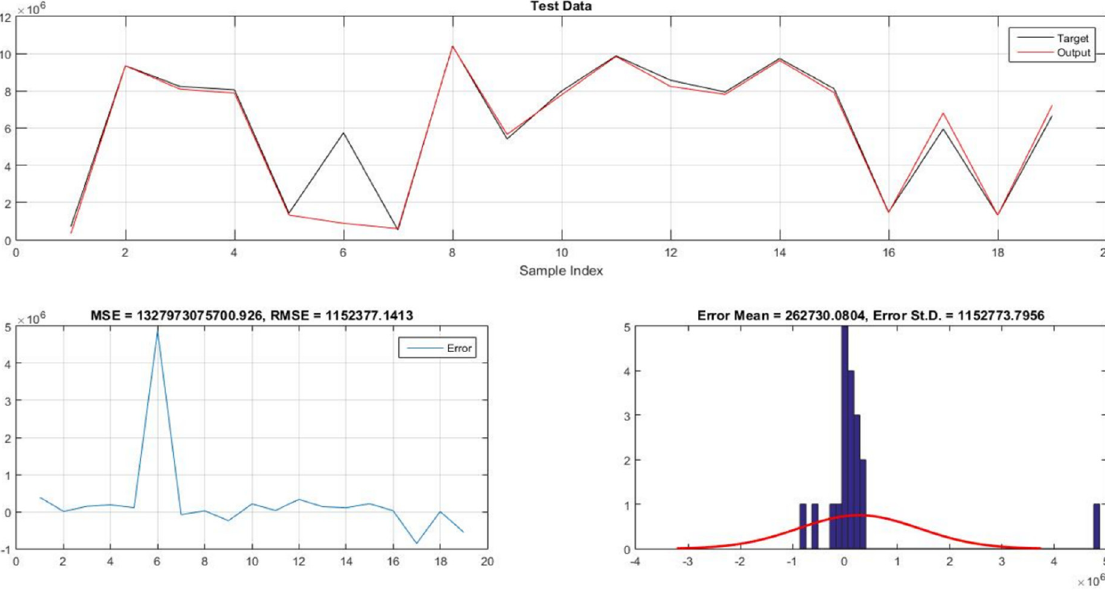
Figure 10. The ANFIS-PSO model showing the testing of the traffic dataset.